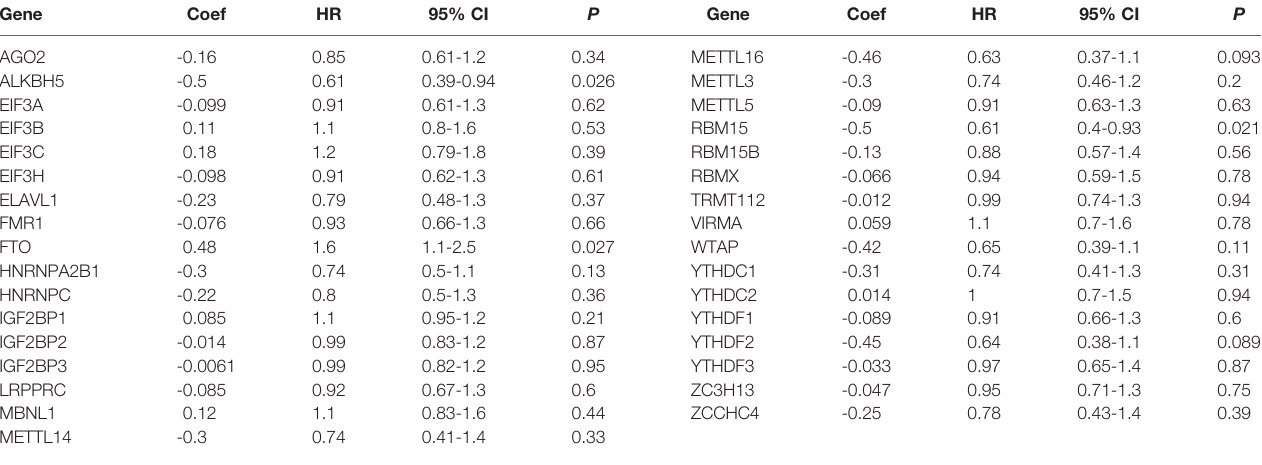
TABLE 1 | The univariate Cox regression analysis of m6A RNA methylation regulators for OS in GC. Gene Coef HR 95% CI P Gene Coef HR 95% CI P AGO2 -0.16